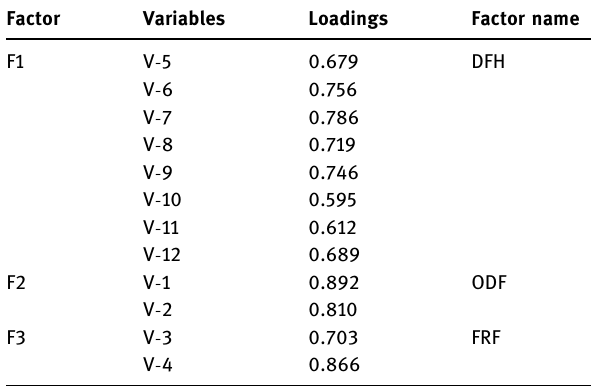
Table 3: Anti - image MSA values for the 13 variables included in the study Variable No.